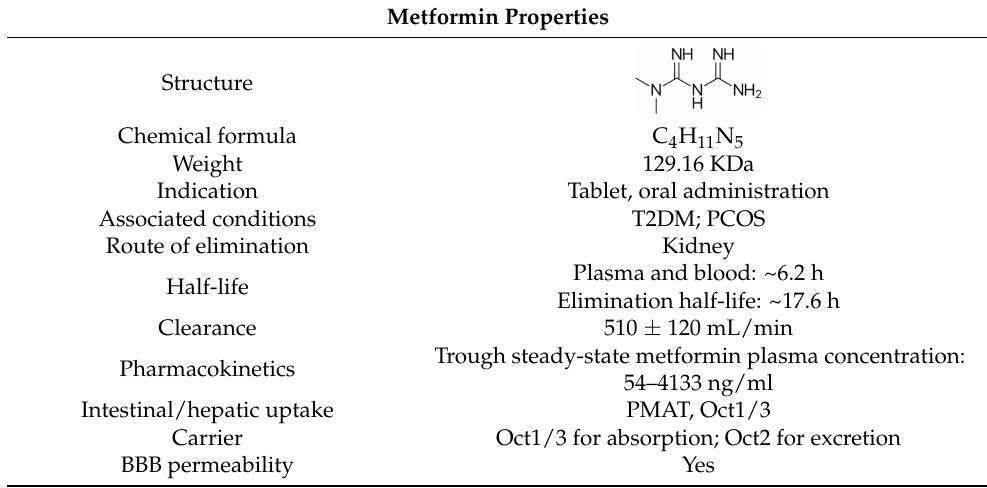
Table 1. Pharmacokinetics, pharmacodynamics and chemical properties of